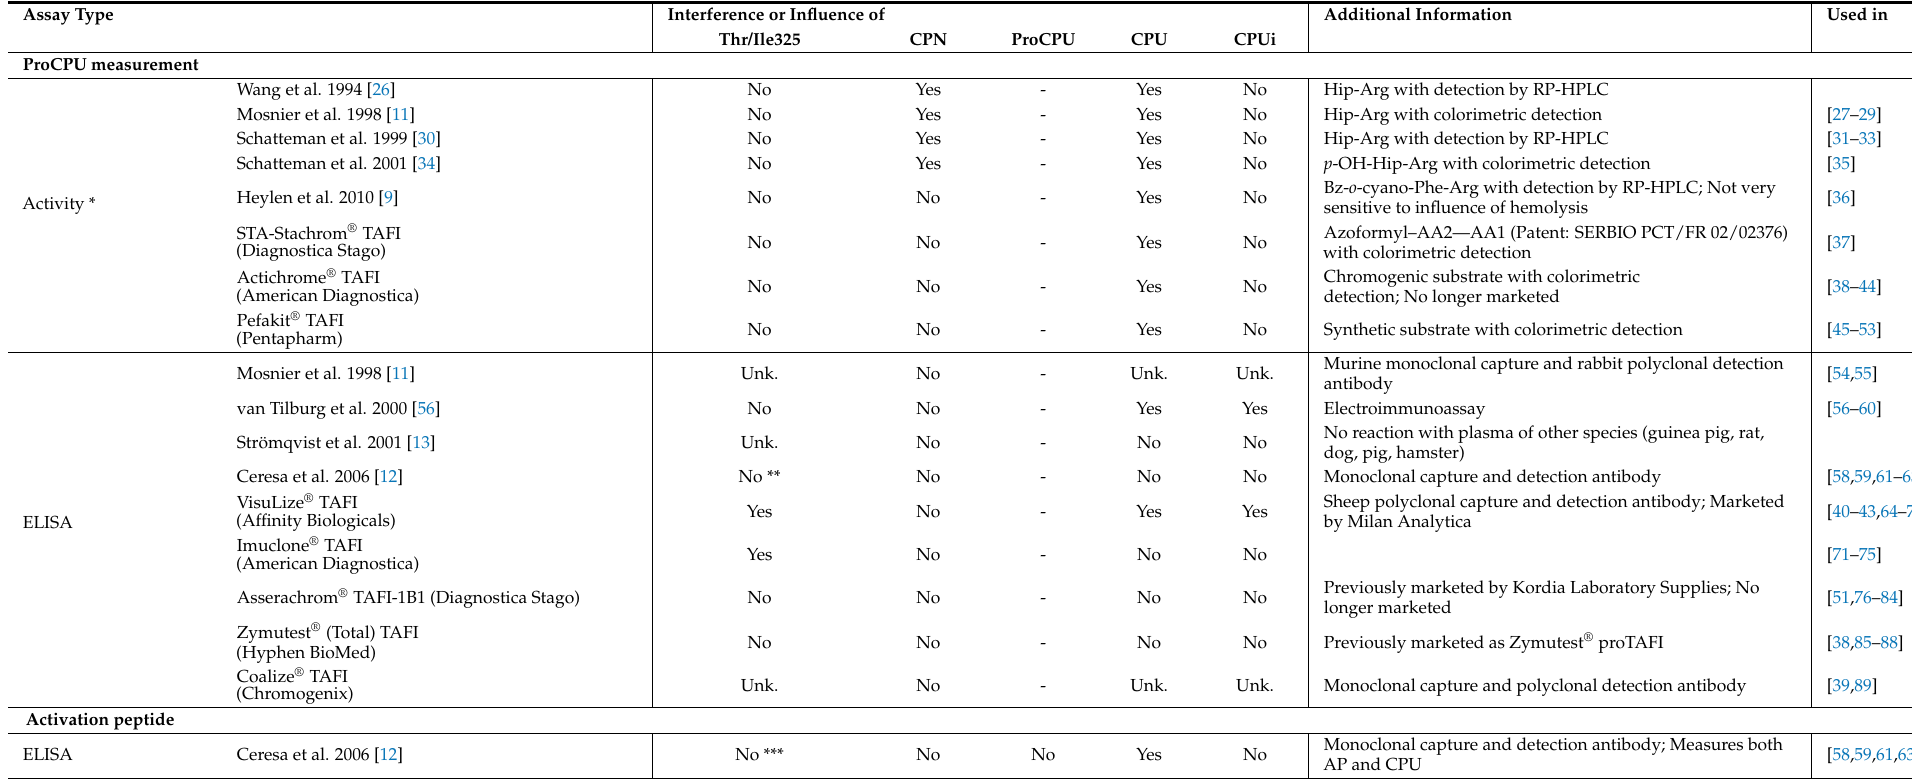
Table 1. Overview of in-house developed assays and commercially available quantification kits for the determination of different forms of the CPB2 gene product in human plasma. Assay